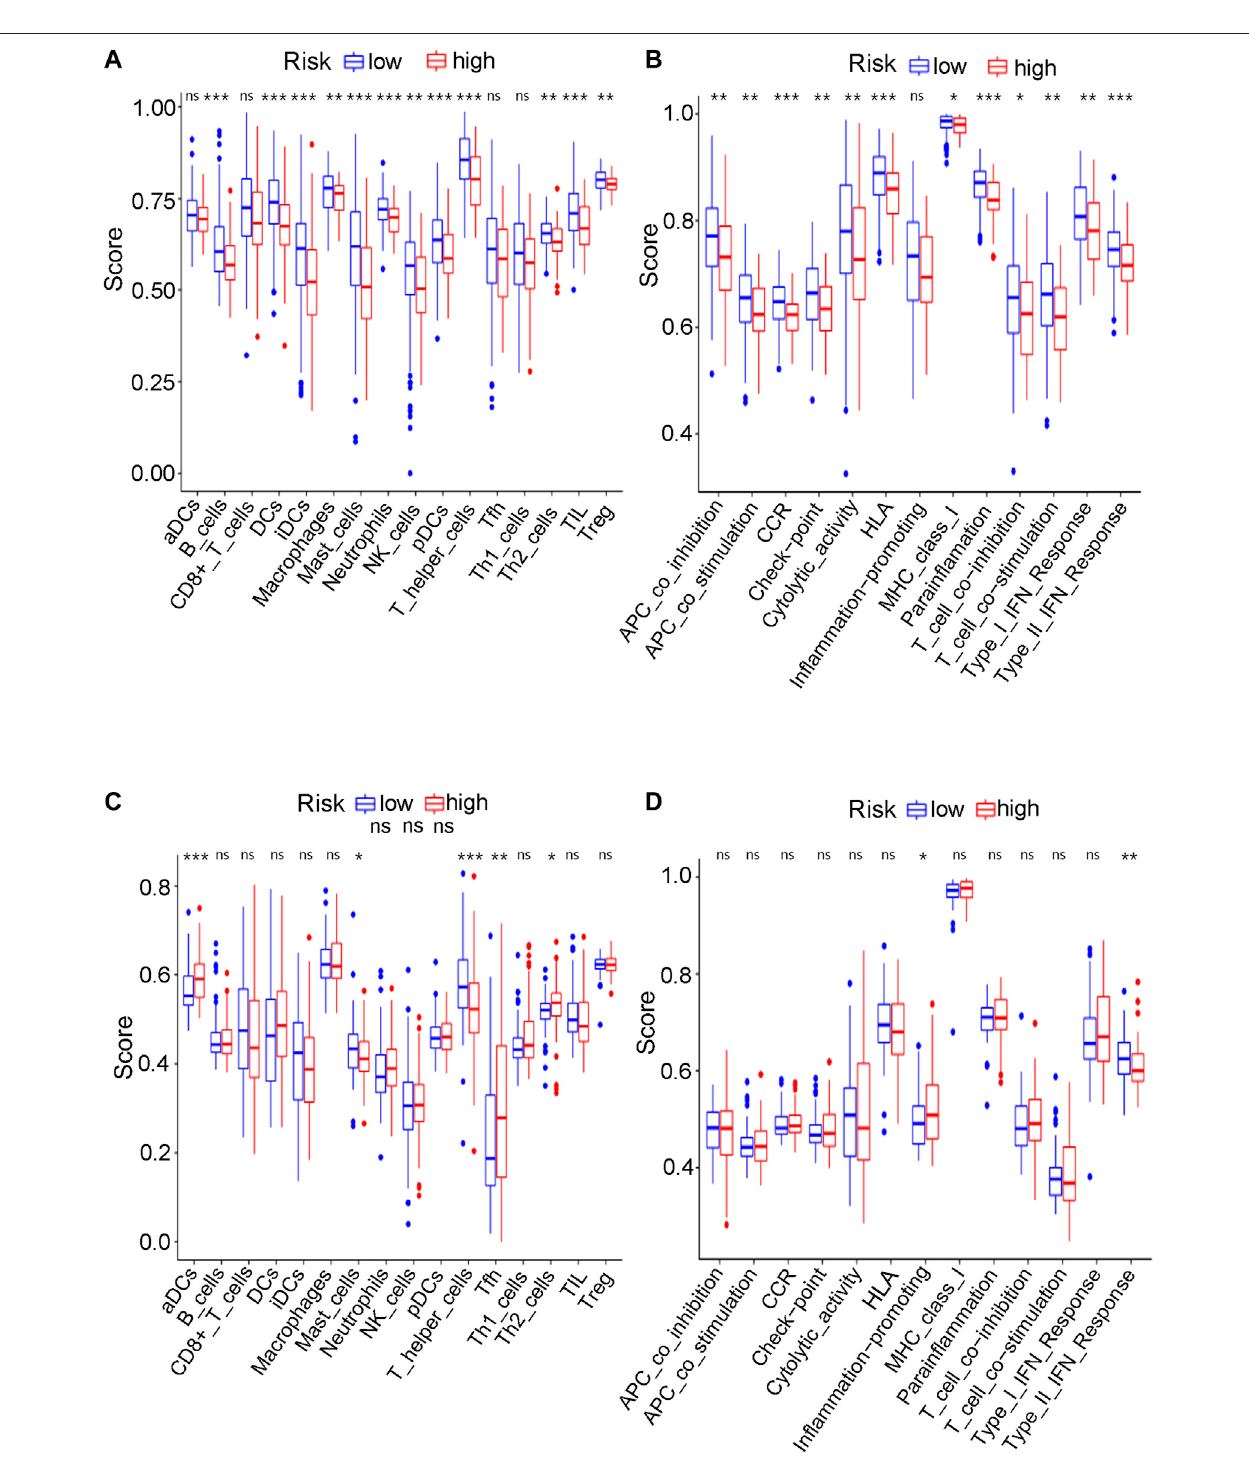
FIGURE12| ThessGSEAanalysisresults. (A) Thedifferenceofin fi ltratingscoreforimmunecellsinTCGAcohort. (B) Thedifferenceofin fi ltratingscoreforimmune- relatedpathways ’ activityinTCGAcohort. (C) Thedifferenceofin fi ltratingscoreforimmunecellsinGEOcohort. (D) Thedifferenceofin fi ltratingscoreforimmune-related pathways ’ activity in GEO